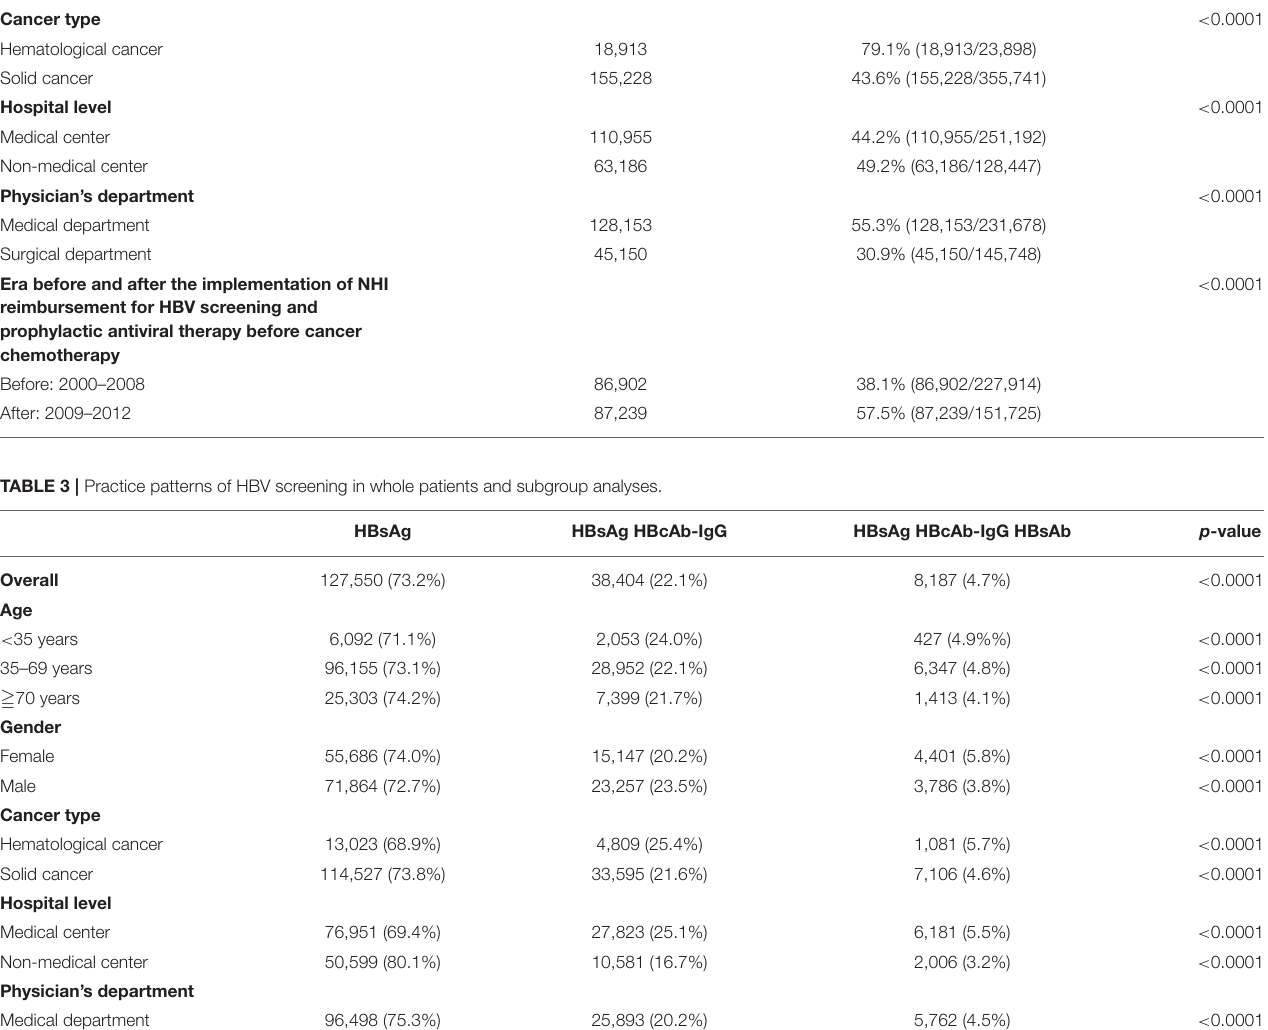
Number of patients